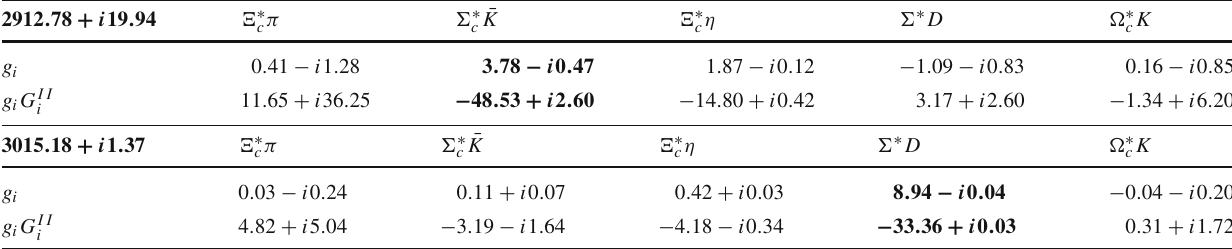
Table 18 The coupling constants to various pseudoscalar-baryon channels and g i G II (all units are in